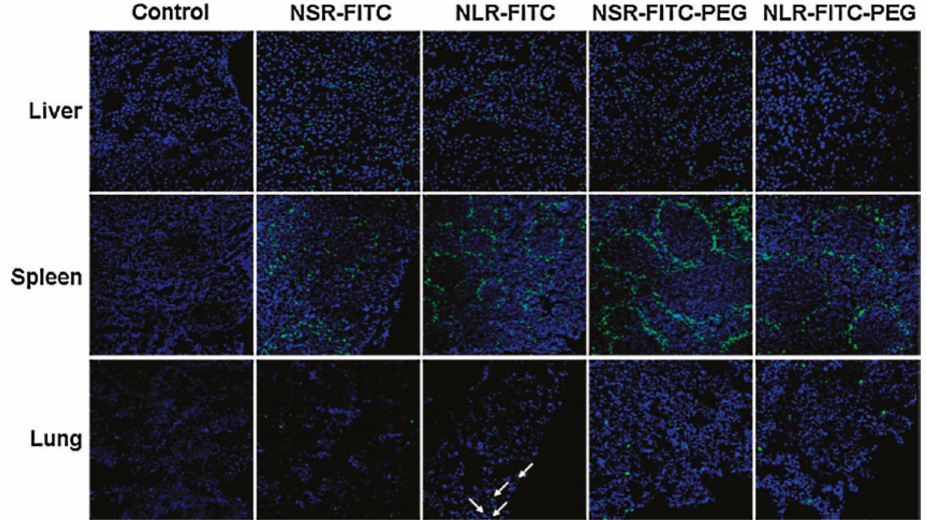
Figure 11. Biodistribution of differently shaped and poly(ethylene glycol) (PEG)ylated MSNFITC in liver, spleen, and lung observed by confocal microscopy 2 h after intravenous injection. Arrows denote NLRFITC distribution in the lung. Reproduced with permission from [30], American Chemical Society,